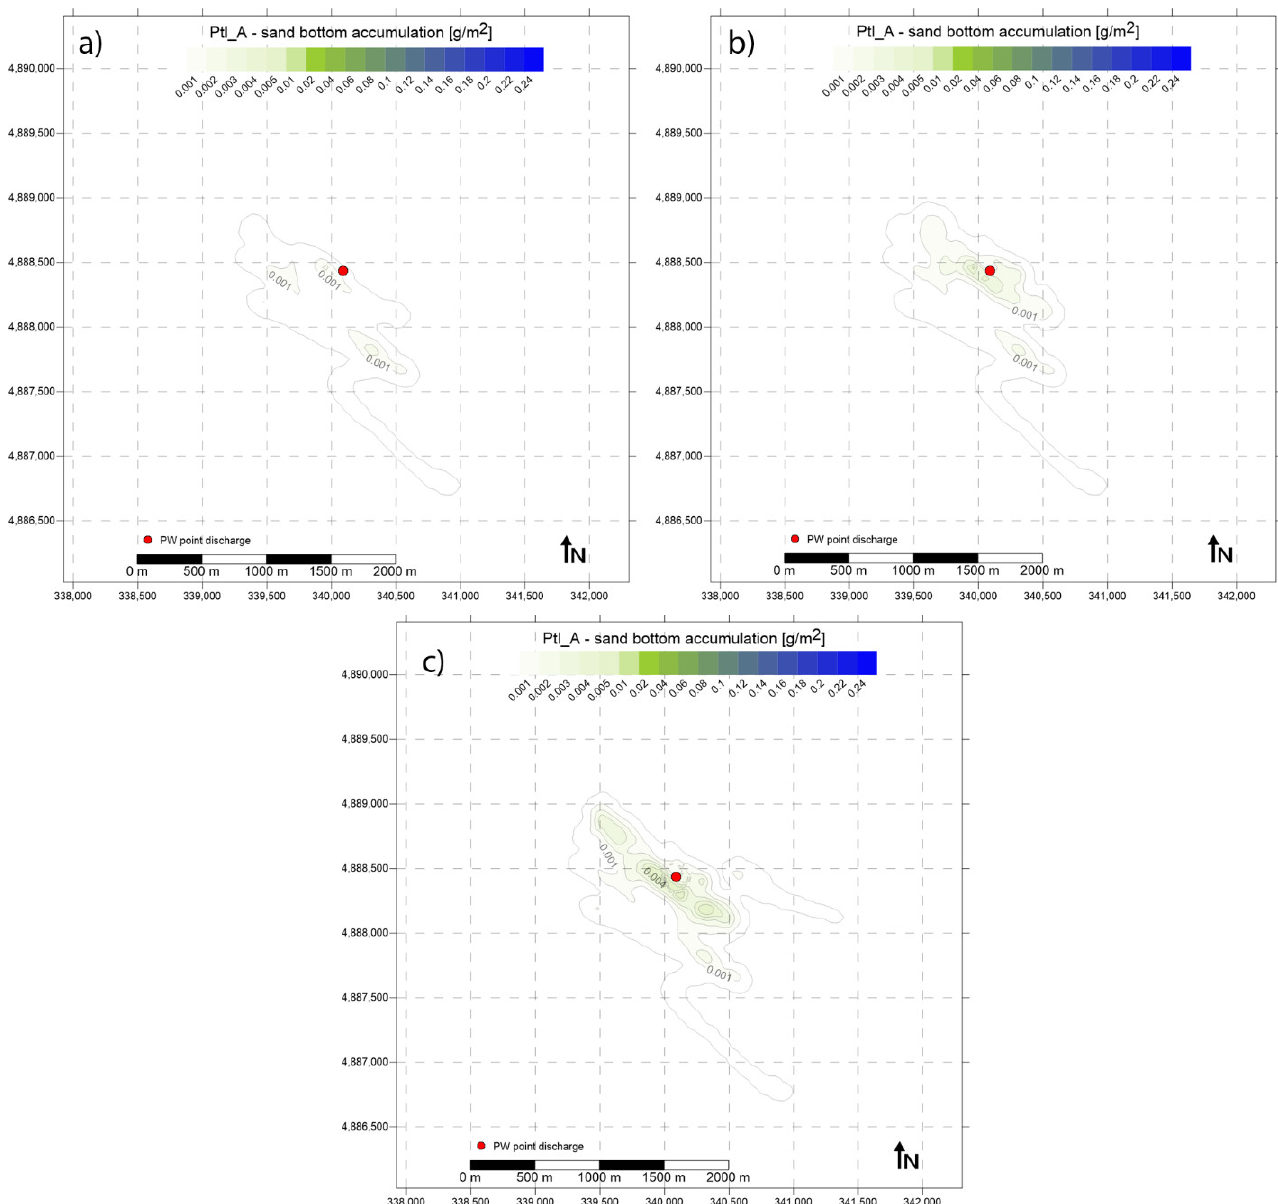
Figure 9. Map (WGS 84 UTM 33N) of sand bottom accumulation ( a ) after 10 days, ( b ) after 20 days, and ( c ) after one month as resulting by MIKE 3 PT module output for Plt A (red dot).